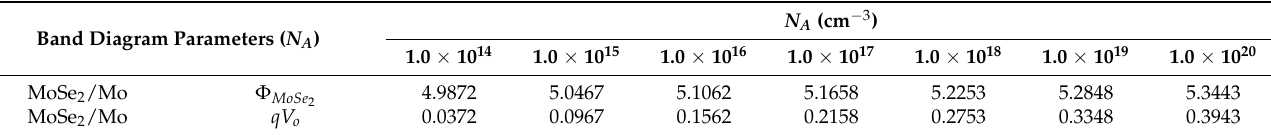
Table 3. Calculated Interface Electronic Parameters of Mo/MoSe 2 in Various N A of MoSe 2 . Band Diagram Parameters ( N A